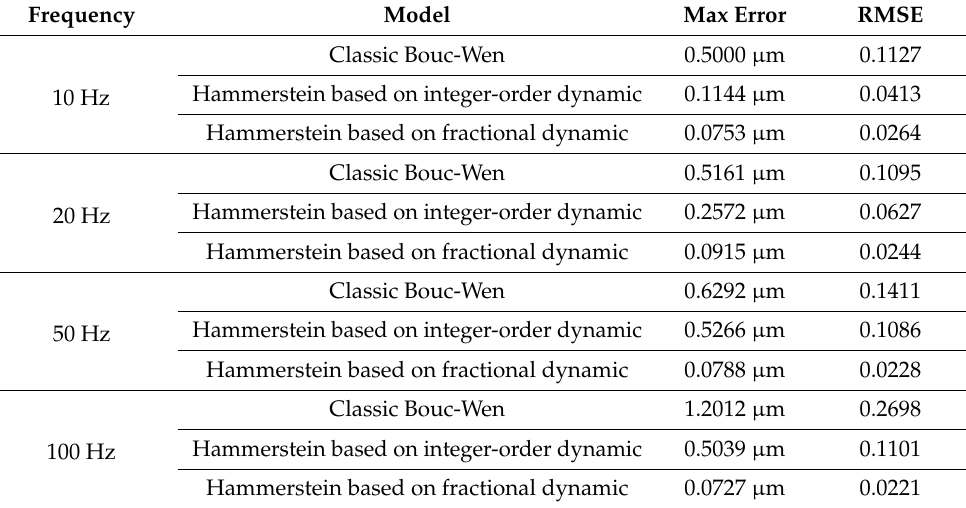
Table 3. RMSE and Max error of the